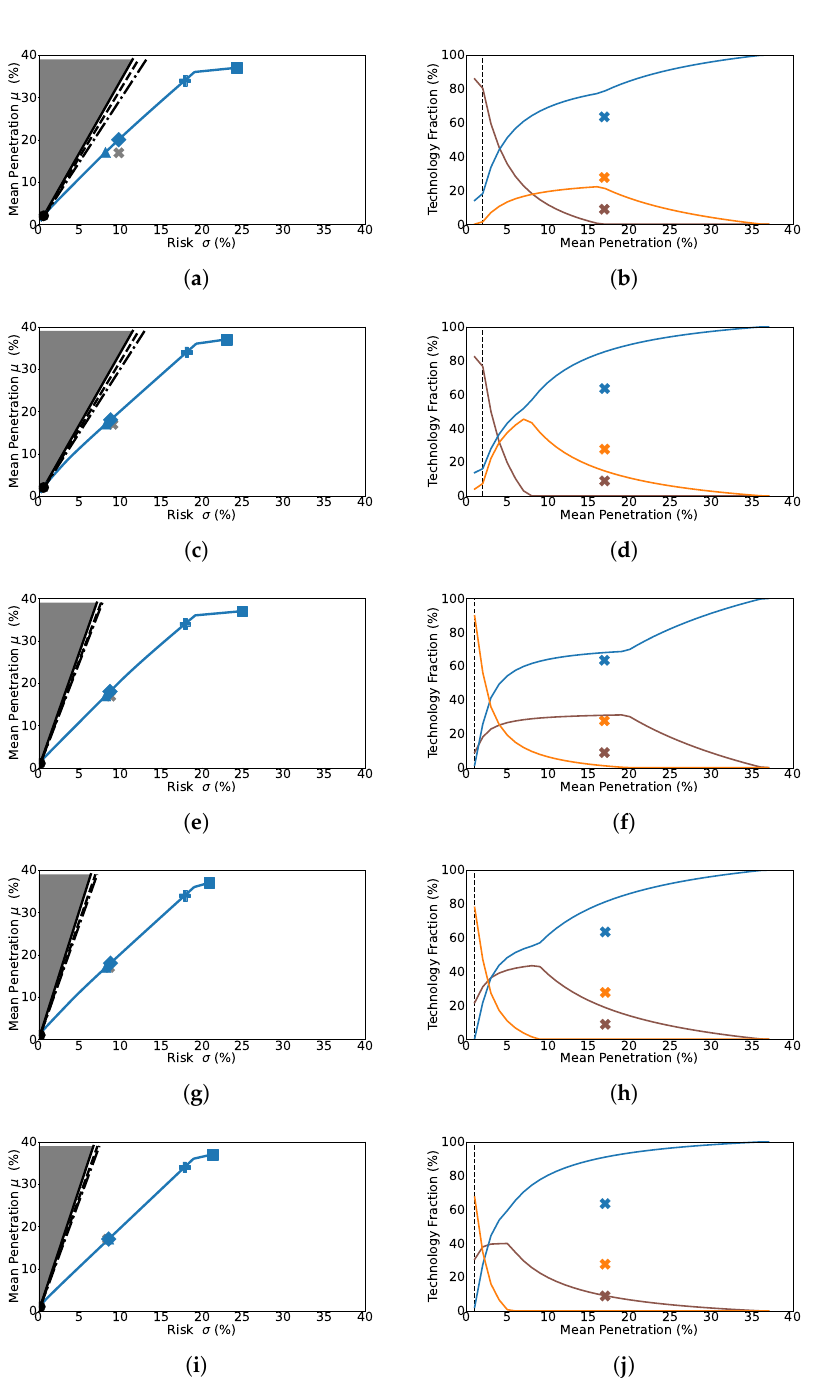
Figure 5. Similar to Figure 4. ( a , b ) PV-ILR4-Wind-CSP-TES SM2; ( c , d ) PV-ILR4-Wind-CSP-TES SM3; ( e , f ) PV-ILR2-Wind-CSP-TES SM4; ( g , h ) PV-ILR3-Wind-CSP-TES SM4; ( i , j ) PV-ILR4-Wind-CSP-TES SM4. The fraction of PV-BES (plain brown line), wind (blue plain line), CSP/CSP-TES (orange plain line) capacities summed over all four regions along the global constrained frontier are shown in the right panels of Figures 4 and 5. The dashed vertical black line corresponds to the optimal mix with the highest penetration that can be achieved before the total-cost constraint becomes active (black dot in the left panel). For each penetration regime, we use the ratios described in ([51], Appendix D) to analyse the relevant contributing factors or the conditions under which the high cost of CSP—considering its benefits of dispatchable energy provided by its cheap TES—can provide an advantage against the low-cost PV combined with costly BES so as to be part of the mix until a more advantageous condition